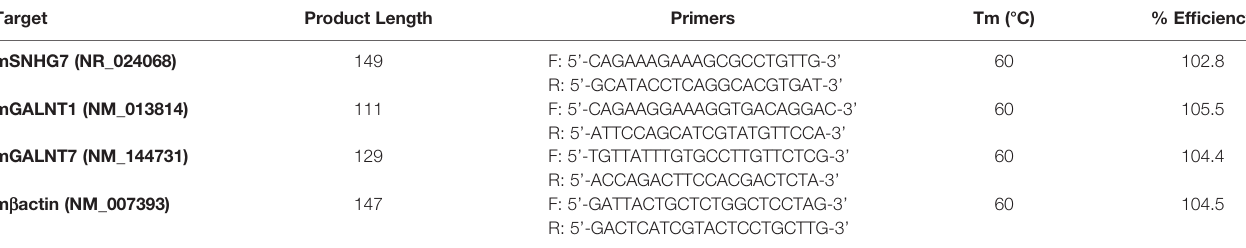
TABLE 1 | Primers for